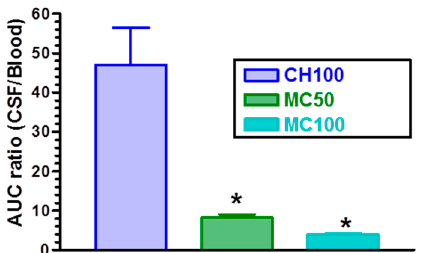
Figure 8. Ratios between CPA area under concentration curves (AUC) values between CSF and bloodstream obtained after nasal administration of the loaded microparticles CH100, MC50 and MC100. Data are expressed as the mean ± standard deviation, n = 4. * p < 0.001 versus CH100.